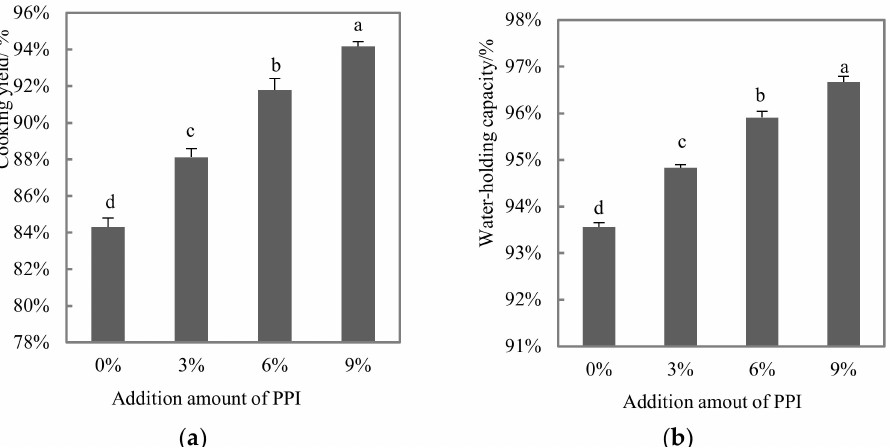
Figure 2. Effect of a pea protein addition level on the cooking yield ( a ) and water-holding capacity ( b ) of duck meat batters. Note: 0%, 3%, 6% and 9% indicated level of addition of PPI to DBM. Data of the cooking yield are the water-holding capacity, expressed as the mean ± SD ( n = 3). Different letters (a–d) indicate a significant difference ( p <